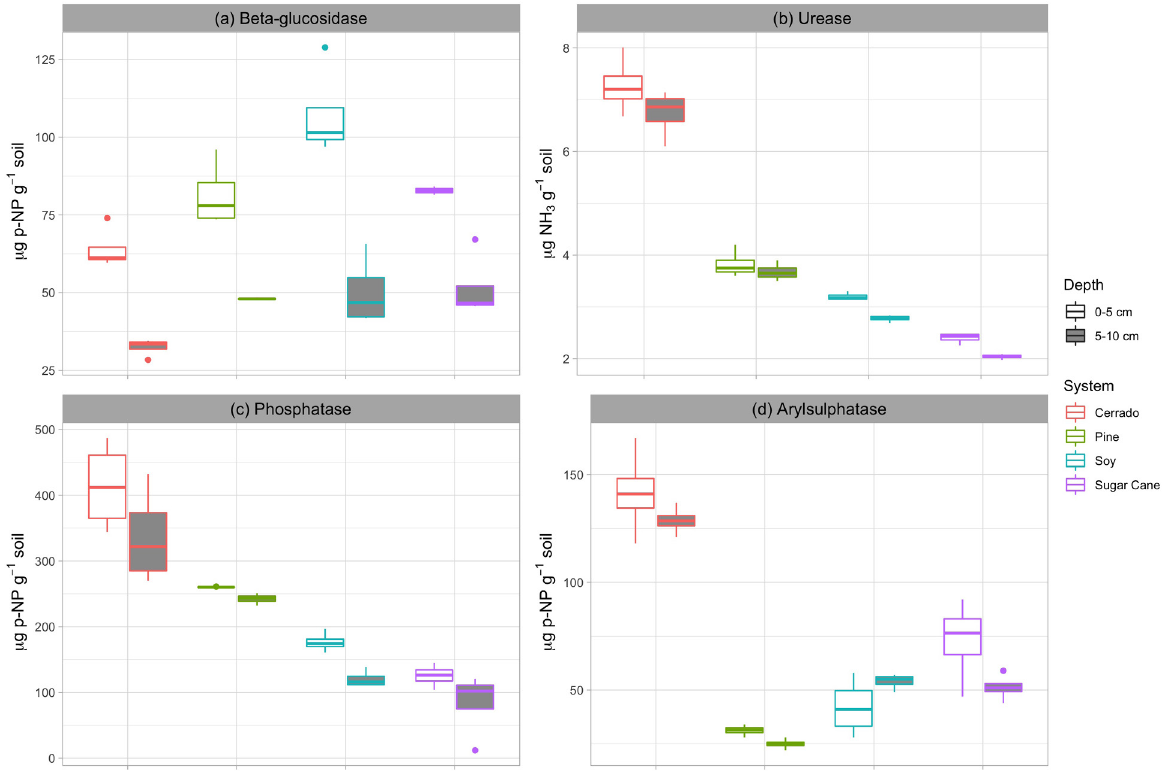
Figure 3 Soil biochemical indicators in different land- uses and soil depths in the Brazilian Cerrado. (a), β-glucosidase activity (ug p-NP g -1 soil h -1 ); (b), urease activity (ug NH g -1 soil h -1 ); (d), arylsulphatase activity (ug p-NP g -1 soil h -1 ). Result of each indicator within land use and depth is indicated by box-plots